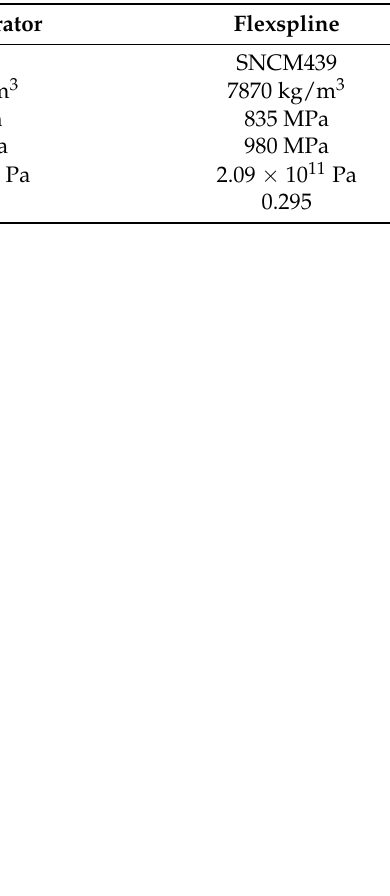
Table 3. The material parameters of the flexspline and wave generator in FEM.